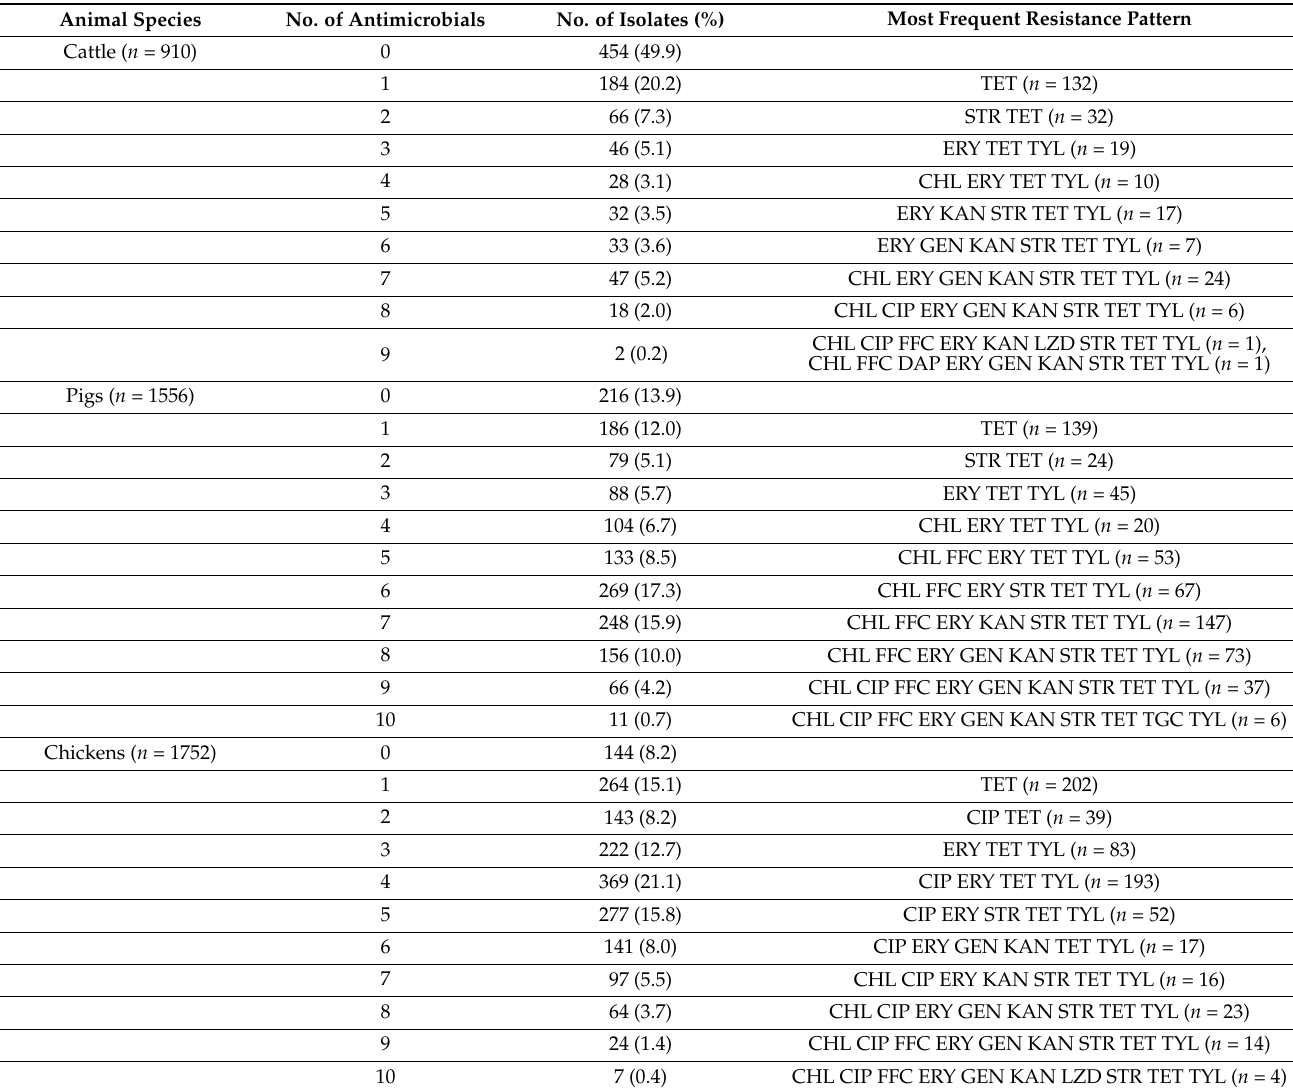
Table 3. Frequent resistance patterns in E. faecalis isolates ( n = 4218) recovered from cattle, pigs, and chickens between 2010 and 2019 in